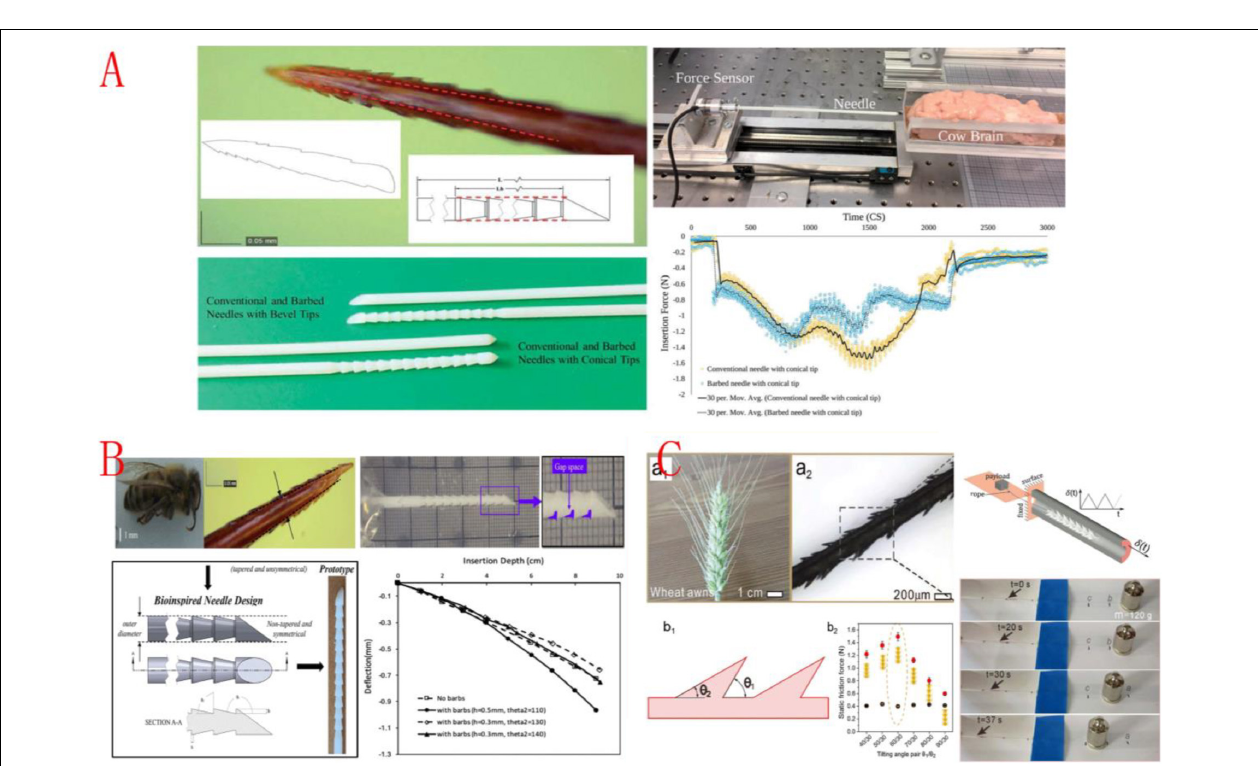
FIGURE 4 | (A) 3D bioinspired needles with specially designed barbs for decreasing insertion force (Sahlabadi et al., 2017). Reproduced with the permission of the Society of Medical Innovation and Technology, 2017. (B) Stinger needles, inspired by honeybee for decreasing tissue damage (Sahlabadi et al., 2017). Reproduced with the permission of 2018 by ASME. (C) 3D printed needle-like anisotropic polymer microactuators, inspired by the microstructure of wheat awn (Ma et al., 2019). Reproduced with the permission of 2018 WILEY-VCH Verlag GmbH & Co. KGaA, Weinheim.